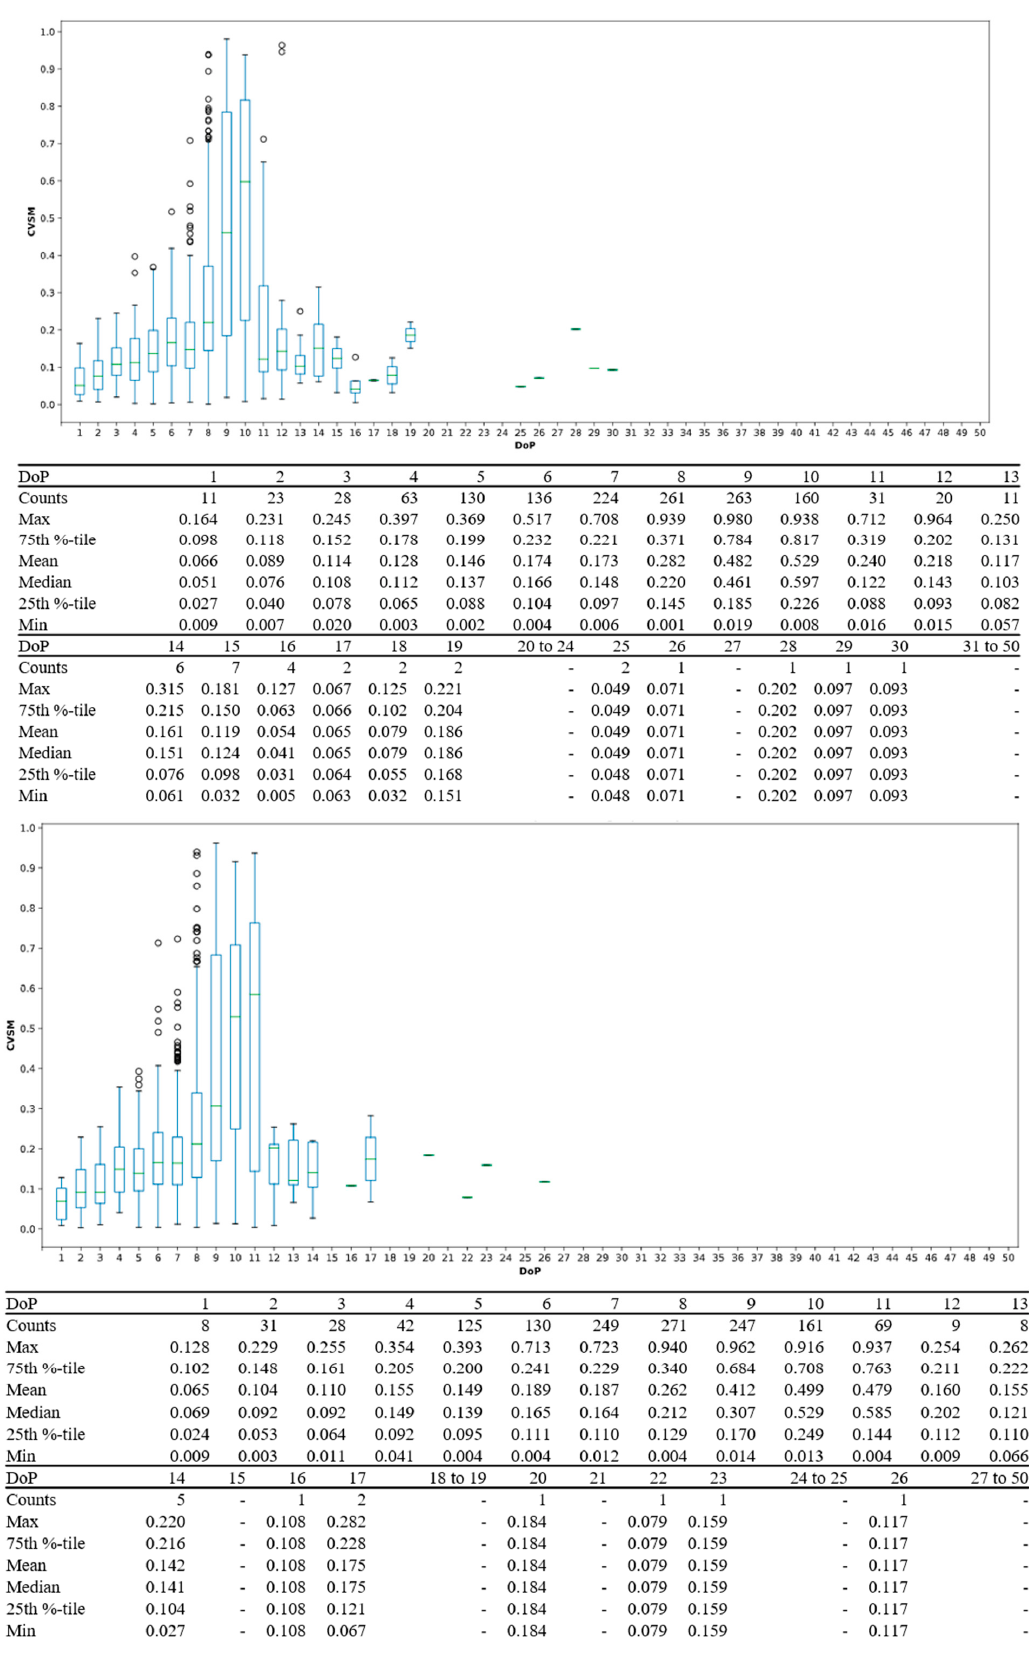
Figure 7. CVSM spread per DoP in IJ dataset. Left wrist ( top ) and right wrist ( bottom ). PJ and IJ DoP distributions of highest CVSM per dataset were shown to have coin- ciding single peak DoP distributions, shown as discrete histograms in Figure 5. It was observed that PJ distribution peaked between 7th and 8th DoP and IJ distribution also peaked at 8th DoP. In earlier pilot study using finger clip PPG sensor, peaks showed a single dominant DoP as it was easily achievable on a single subject [20], when compared to wristbands, two DoP peaks in PJ datasets were observed due to the change in sensor form factor and wider study population. Nonetheless, coinciding peaks meant PJ and IJ DoPs were desirable to be used for correlation and that inherent algorithm design and definitions were sound to represent patient condition. Extending DoP search to 50th DoP showed no other mode of DoP peaks existed as there were no significant occurrence beyond 20th DoP. For PJ, lowest DoP occurrence was from left wrist single instance at 4th DoP while highest was also single instance but from right wrist at 16th DoP. Whereas for IJ, lowest DoP occurrence was 133 instances at 1st DoP while the highest was a single instance from right wrist at 40th DoP. The original search boundary of 1st to 20th DoP was adequate to model PPG data for both PJ and IJ datasets. Single peak DoP distribution study was applied uniformly across 35 subjects with peaks observed between 7th and 10th DoP without any peculiarities in PJ datasets as shown in Figure 8. The algorithm could be used on a wider demographic, regardless of age.